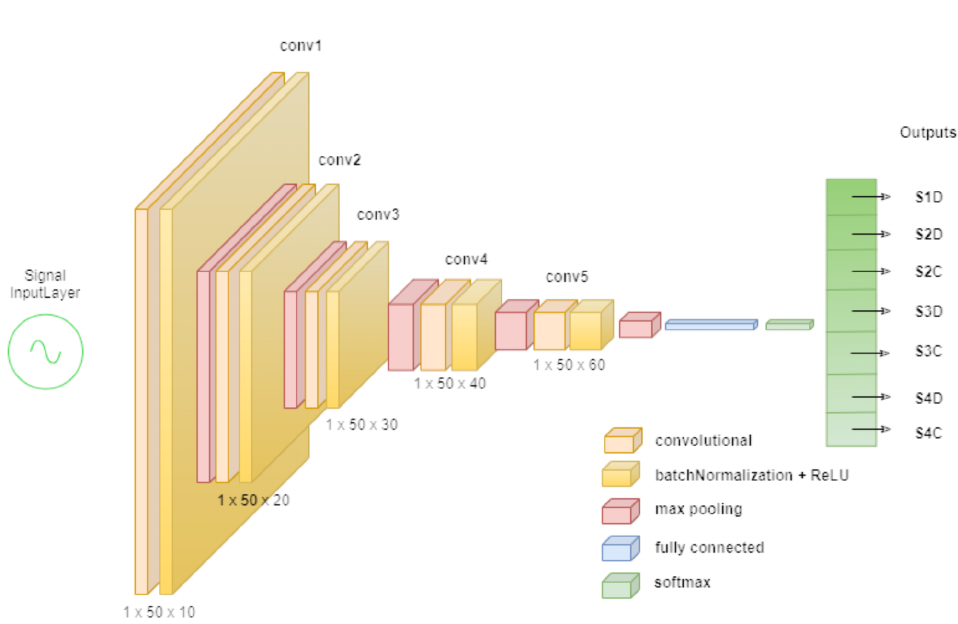
Figure 5. DCNN architecture (S: shape, D: decentered, C: